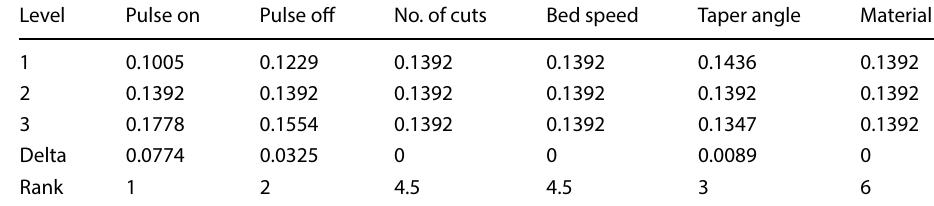
Table 14 Response table for ) means ( R a